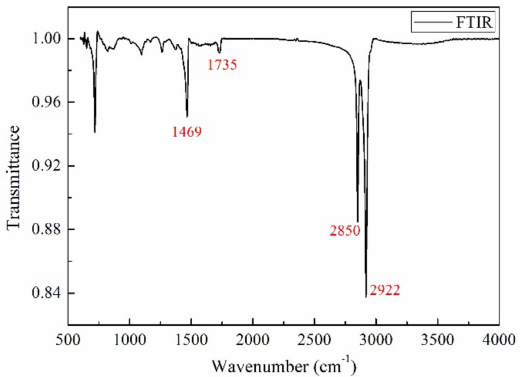
Figure 1. Fourier transform infrared spectroscopy (FTIR) image of semi-conductive composites.